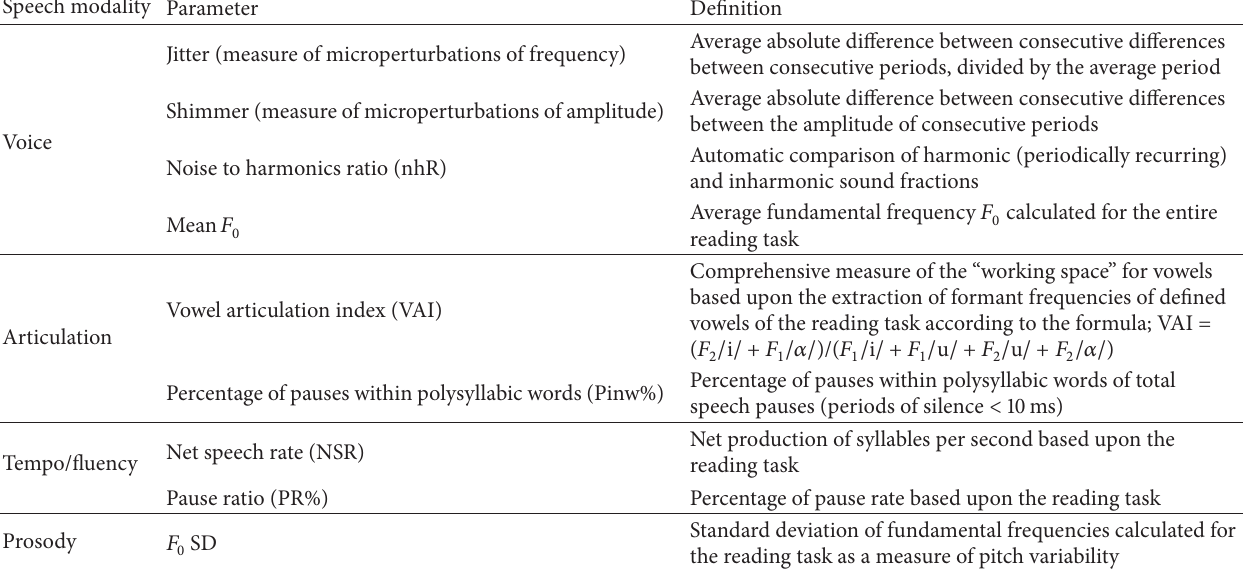
Table 3: Abbreviations and definitions of the speech